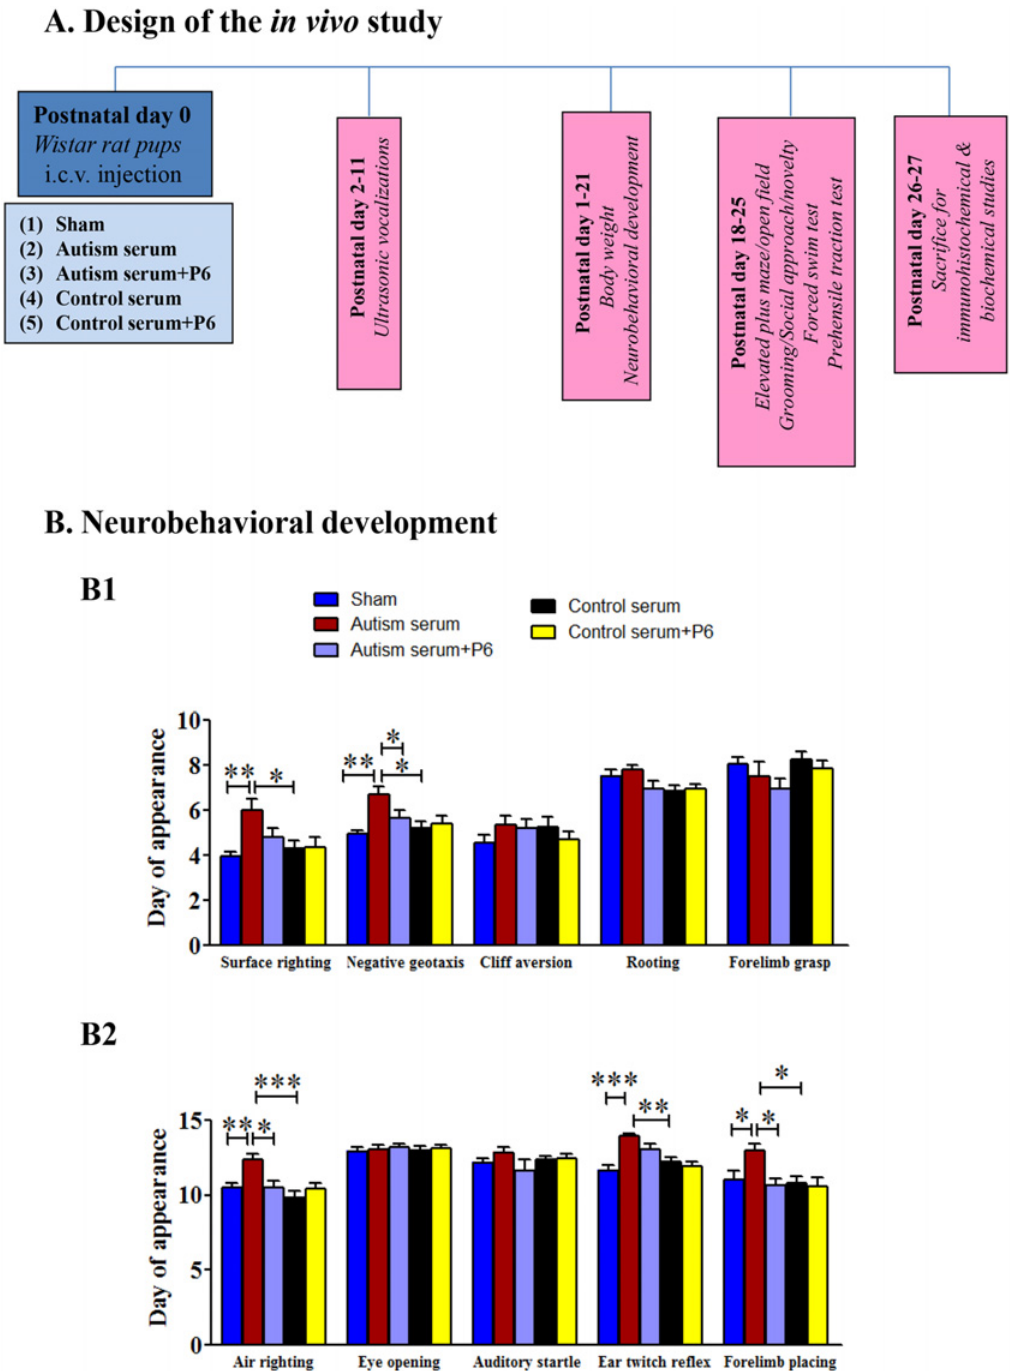
Fig 3. Design of the in vivo study and the effects of autism and control sera in the presence or absence of P6 on neurobehavioral development in rats. ( A ) Newly born Wistar rat pups were injected intracerebroventricularly on on postnatal day (P) 0.5 with saline (sham) or 2% autism or control serum with or without 20 nM P6. Behavioral studies were performed from postnatal day 2 to 25 in rats. ( B ) Evaluation of neurobehavioral development in Wistar rat pups from postnatal day 1 – 21( B1 ) Day of appearance of surface righting, negative geotaxis, cliff aversion, rooting, and forelimb grasp and ( B2 ) air righting, eye opening, auditory startle, ear twitch, and fore limb placing. Data are presented as mean ± S.E.M. based on sham (n = 17), autism serum (n = 15 – 16), autism serum+P6 (n = 16 – 17), control serum (n = 15 – 16), and control serum+P6 (n = 16 – 17). * p < 0.05, ** p < 0.01, and *** p < 0.001. ANOVA with Bonferroni ’ s post- hoc test and/or Student ’ s t